Question: What form of chart is displayed?
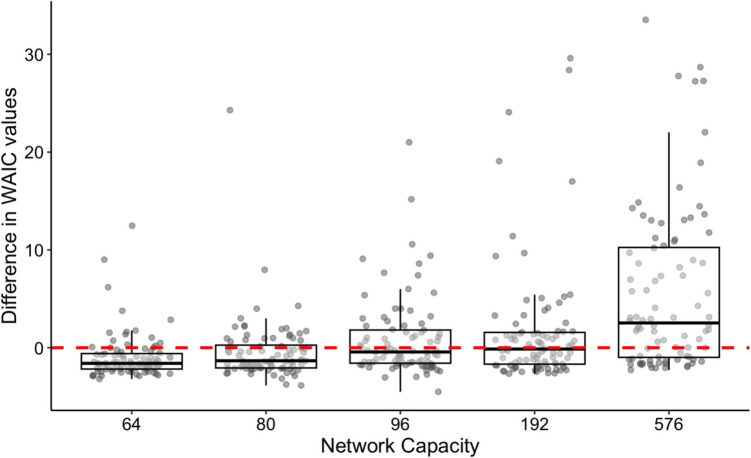
Answer: line